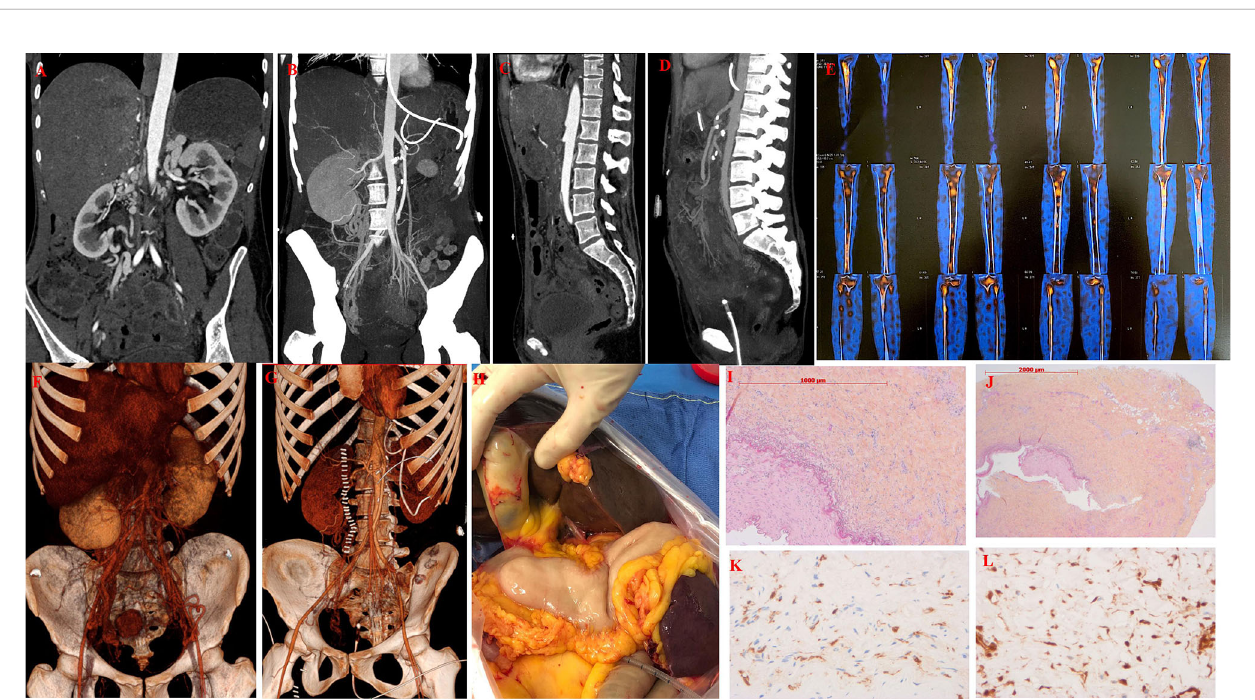
FIGURE 1 | Clinical, radiological, and histological features of Erdheim – Chester Disease. (A) Sagittal computed tomography of the patient showing severe stenosis of superior mesenteric artery responsible for mesenteric ischemia in a patient with ECD. (B) Sagittal computed topography of the patient after thrombectomy and stenting of superior mesentery artery. (C) Coronal view of severe stenosis of superior mesenteric artery responsible for mesenteric ischemia in a patient with ECD. (D) Coronal view after thrombectomy and stenting of superior mesentery artery. (E) Bone scintigraphy showing radiotracer uptake on long bones characteristic of ECD. (F) Maximum intensity sagittal and angio3D projection showing vascular stenosis of coeliac trunk and superior mesentery artery. (G) Maximum intensity sagittal and angio3D projection demonstrates extensive digestive. (H) Maximum intensity sagittal and angio3D projection after digestive removal and vascular stenting. (I) Tissue biopsy of mesentery artery showing fi brosis of vessels adventitia without signs of vasculitis (×100). (J) Same sample showing adventitia fi brosis without signs of vasculitis (×200), (K) Same samples showing tissue in fi ltration with multinucleated histiocytes with CD163 (brown staining) expression on immunostaining.(HES; immunohistochemistry, ×200) consistent with ECD. (L) Same samples showing tissue in fi ltration with multinucleated histiocytes expressing phosphor-Erk (brown staining) HES; immunohistochemistry,